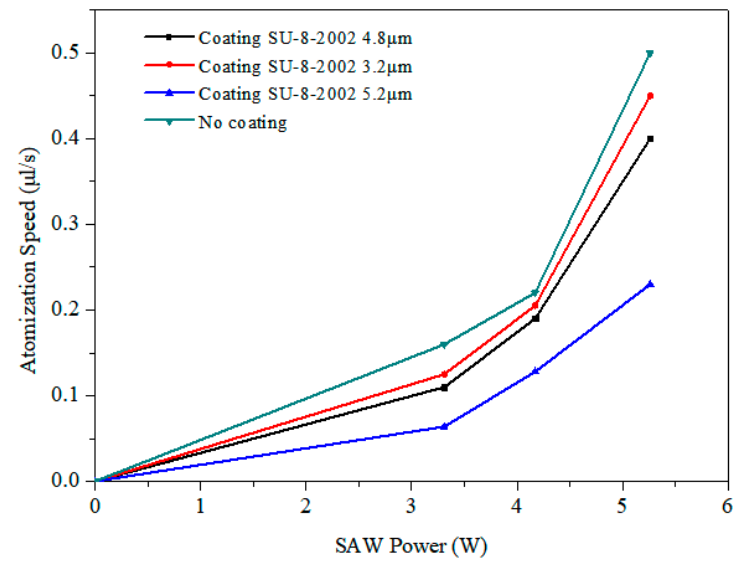
Figure 10. Atomization speed (i.e., droplet volume divided by the total atomization) over the SAW power.